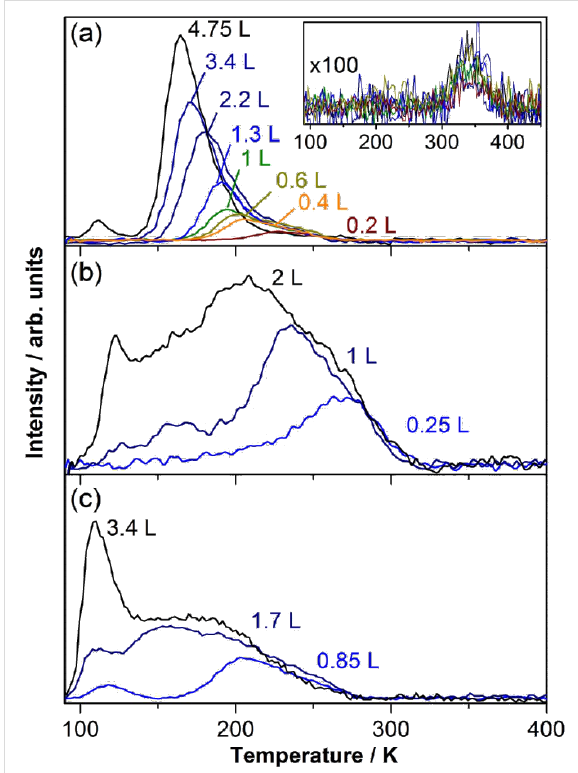
Figure 1: Temperature-programmed desorption/reaction spectra showing the molecular desorption of: (a) CD 3 I, (b) CH 3 Br and (c) CH 3 Cl from a 10 ML Au film on Mo(100). The numbers indicated next to the spectra represent the methyl halide exposure in units of Lang- muir. The inset displays the C 2 D 6 signal evolution. The C 2 D 6 signal intensity has been multiplied by a factor of 100. All spectra were obtained with a heating rate of 2